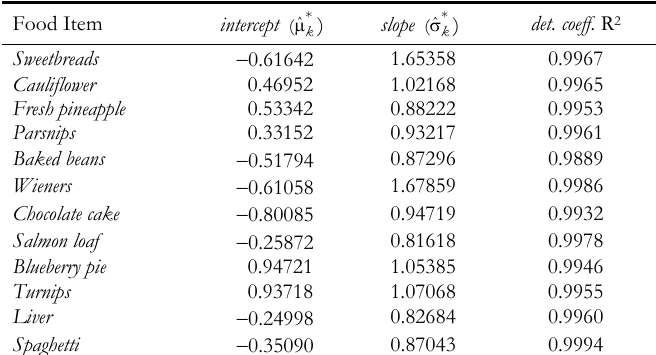
K (cid:93) (cid:32) i k (cid:32) 1